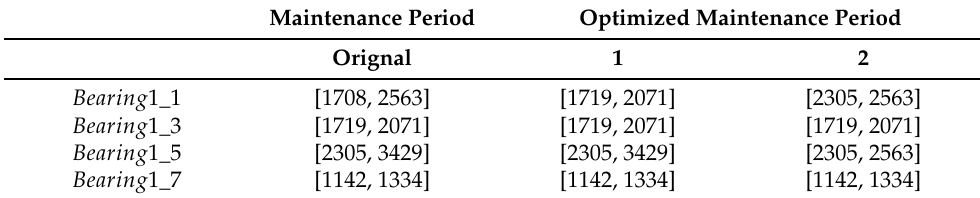
Figure 11. Gantt chart of maintenance scheduling results. Table 4. Detailed results of Maintenance